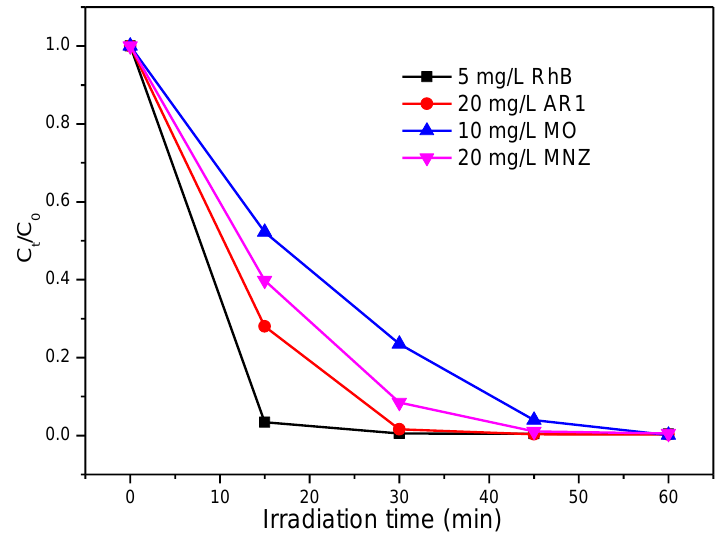
Figure 8. Photocatalytic degradation of single pollutant by Ga 2 O 3 .